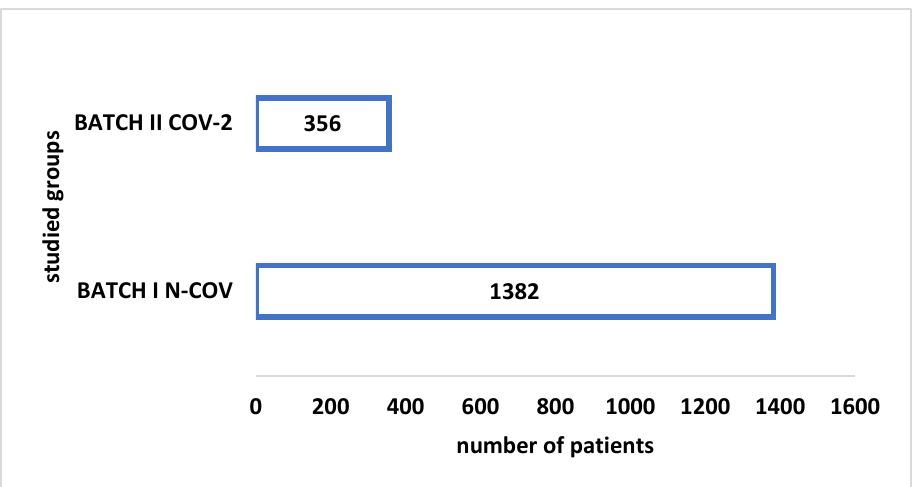
Figure 1 . The number of admitted patients during pre-pandemic (BATCH I N-COV) and pandemic (BATCH II COV-2) years .